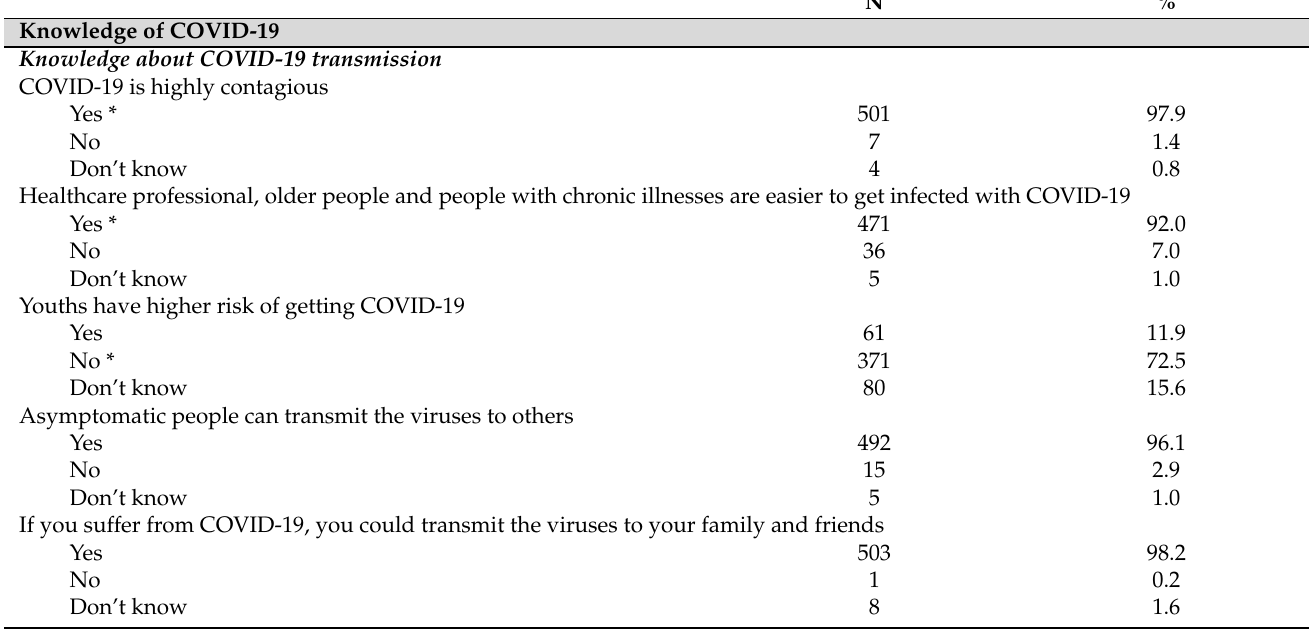
Table 2. Frequency distributions of variables related to receive COVID-19 vaccination perceptions (N =